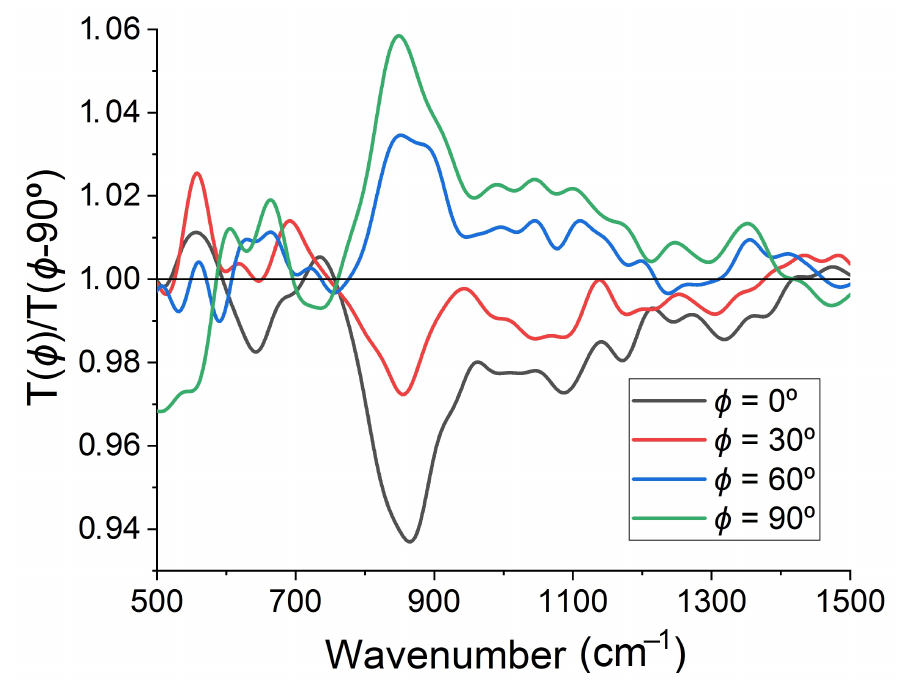
Figure 6. Ratio of the IR transmission spectra T ( φ ) / T ( φ − 90 ◦ ) at polarization angles of φ = 0 ◦ , 30 ◦ ,60 ◦ , and 90 ◦ .